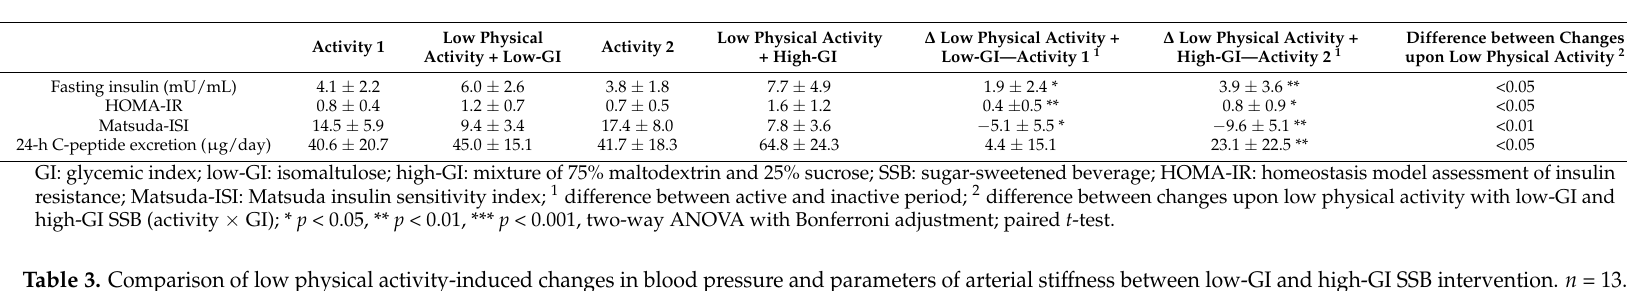
Table 2. Comparison of low physical activity-induced changes in fasting insulin, insulin sensitivity (IS), C-peptide excretion, daylong glycemia and glucose variability between low-GI and high-GI SSB intervention. n = 13.